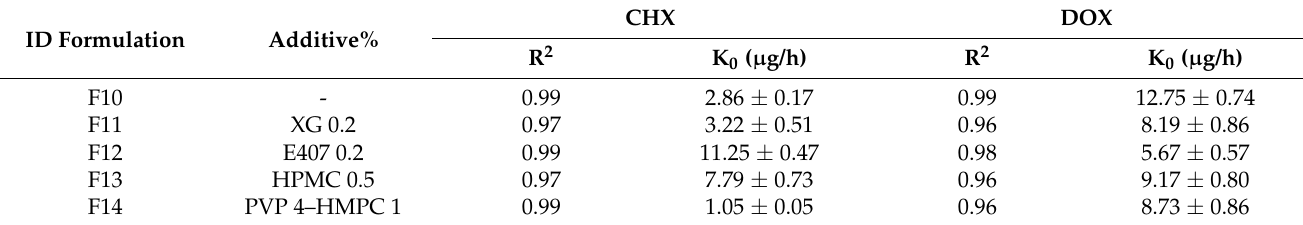
Figure 7. Cumulative percentage of CHX and DOX released over the time. Data are expressed ad mean ± S.D. for n = 3. Table 5. R 2 and K 0 constant ( µ g/h) of different gel formulations.